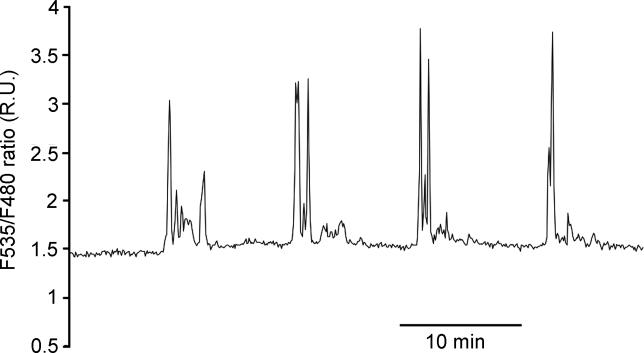
Alterations in the Extracellular Calcium Concentration in the Absence of Changes in the Extracellular Cl− Concentration Cause Large Ratio Changes in YC3.6 in Arabidopsis Guard Cells Illustrating that YC3.6, Like YC2.1, Reports Cytosolic Ca2+ Changes and Not Cl− Changes during Imposed TransientsSee Materials and Methods. The YFP/CFP emission ratio is monitored in a guard cell (wild-type) expressing YC3.6. Ratio increases accompany exposure to high extracellular calcium using the membrane-impermeable counteranion, imminodiacetate.